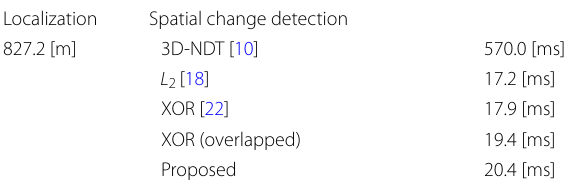
Table 5 Processing time for each step Localization